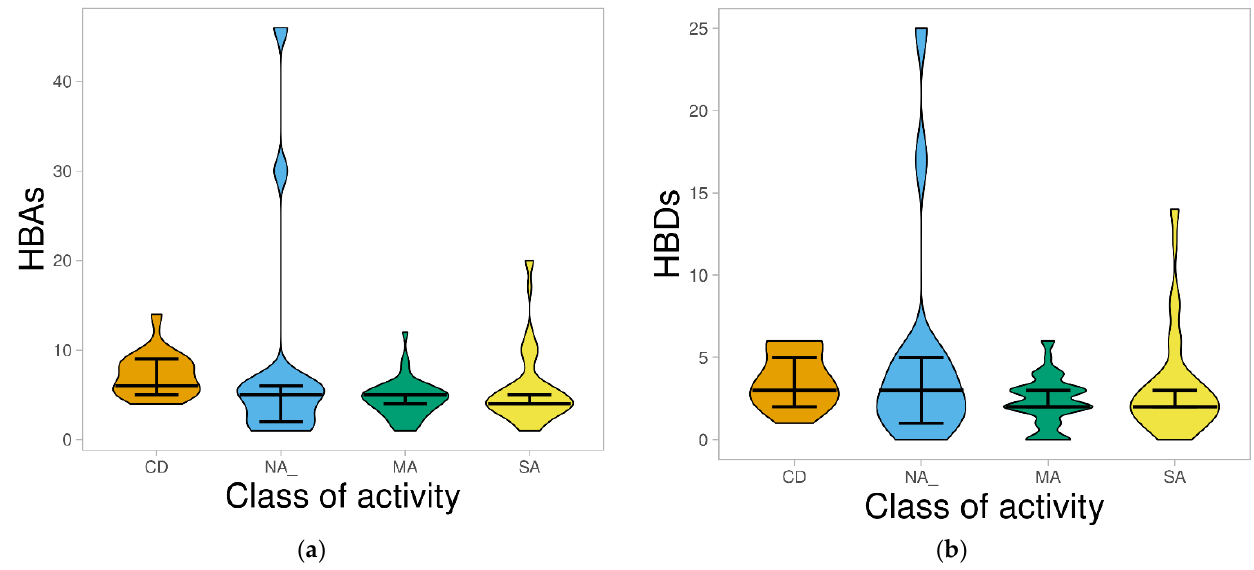
Figure 4. Violin plots of HBAs ( a ) and HBDs ( b ) against the class of activity. The plots show the distribution of CDs compared with the various categories of AMNPs, where the boxes indicate each of the datasets; the line that divides the boxes represents the median of the distributions. The black bars in both figures show a 95% confidence interval.